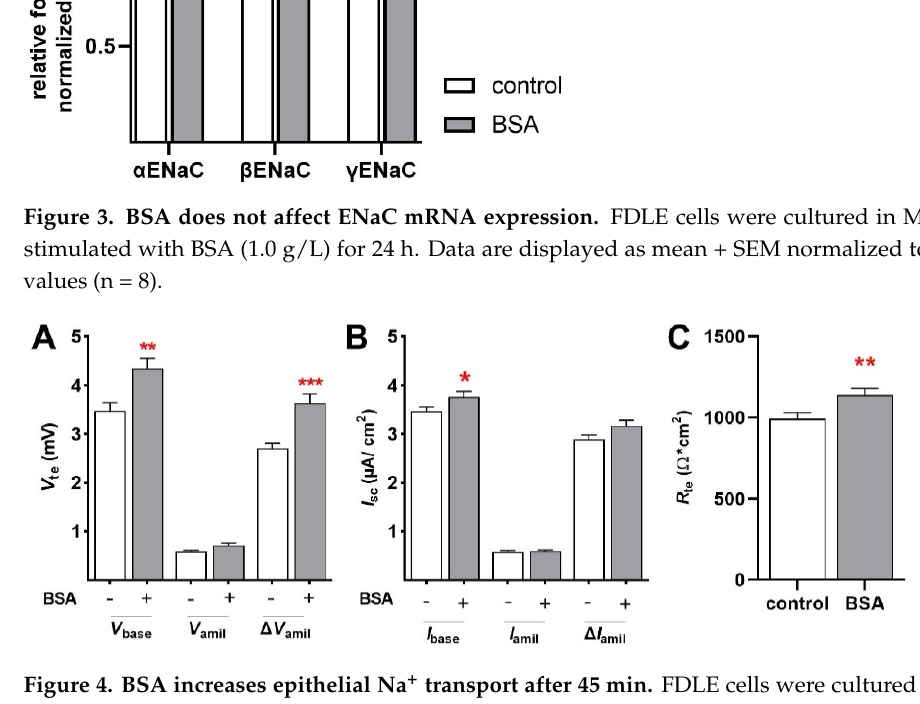
Figure 3. BSA does not affect ENaC mRNA expression. FDLE cells were cultured in MEM and stimulated with BSA (1.0 g/L) for 24 h. Data are displayed as mean + SEM normalized to control values (n = 8).